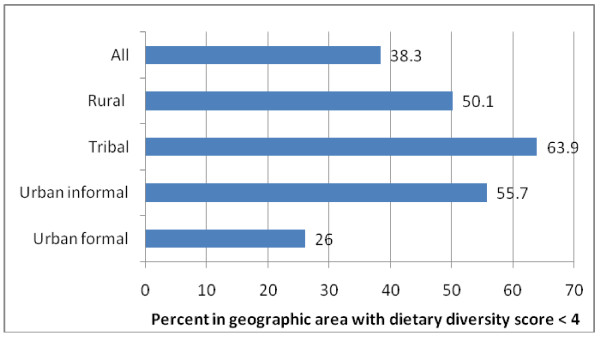
Percent of the population (with 95th CI) with a dietary diversity score less than 4 according to geographic area.